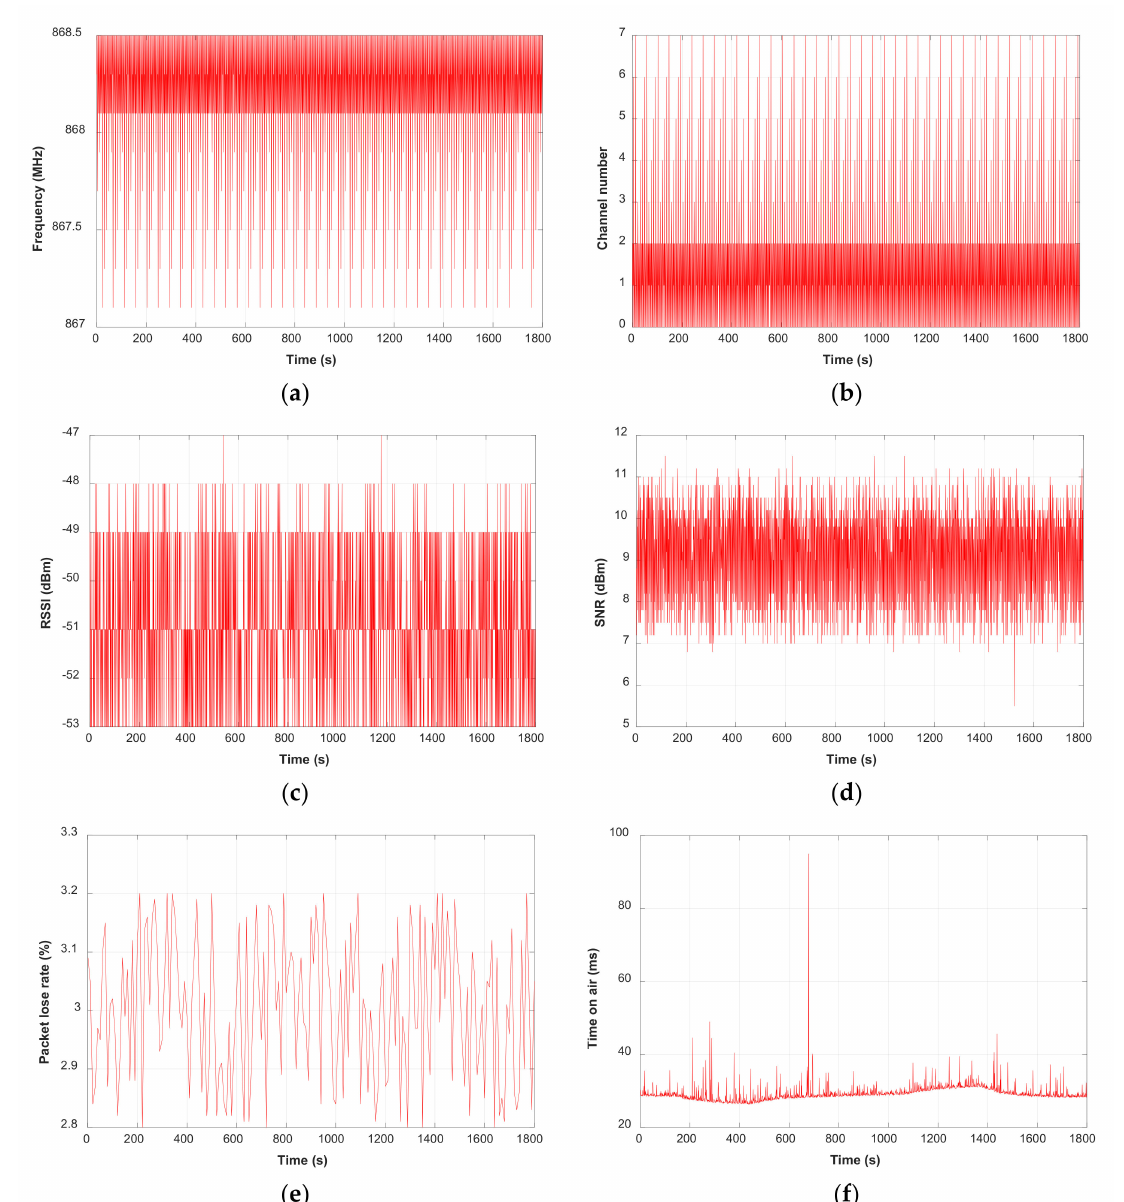
Figure 13. Measurements on the LoRa network: ( a ) frequency; ( b ) channel number; ( c ) RSSI; ( d ) SNR; ( e ) PLR; and ( f ) time on